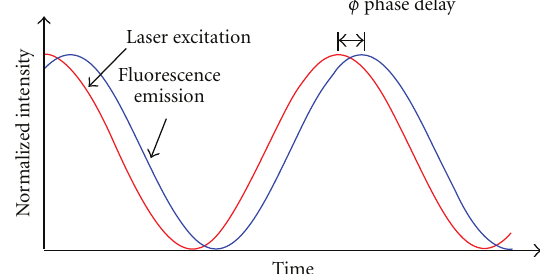
Figure 3: Illustration of the fluorescence lifetime principle. The short-pulsed excitation light (red) and the longer time duration fluorescence emission light (green) is shown as a function of time. In FLIM, the time scale of the fluorescence emission, τ , is measured.